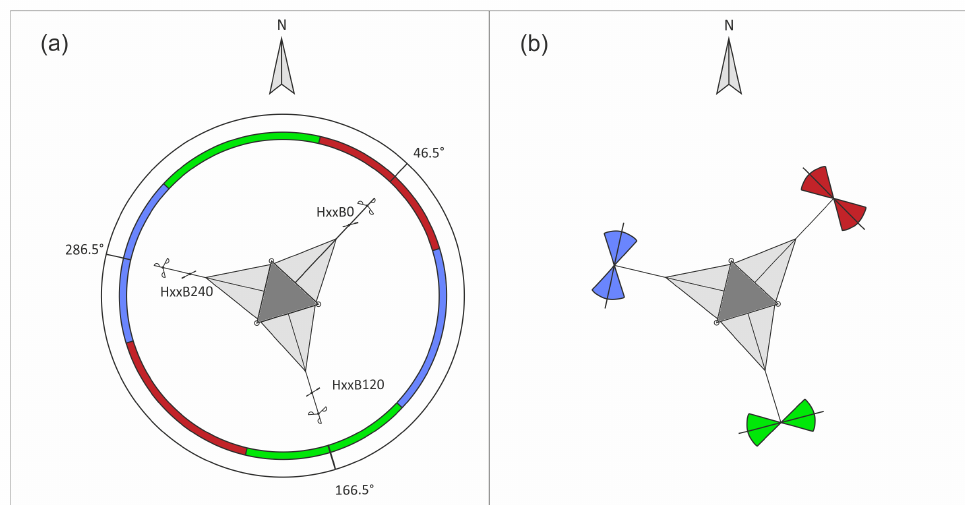
Figure 3. Top view of the mast at IJmuiden. ( a ) Wind vanes and anemometers on each boom (B0, B120, and B240) at the three measurement heights, Hxx (xx = 27, 58.5 and 85 m). Angles indicate boom orientation. (Red, green, and blue) Color-coded circular crown sectors represent the wake-free angle ranges for each anemometer (90° ± 30°, panel ( b )) in relation to boom orientation. Adapted from